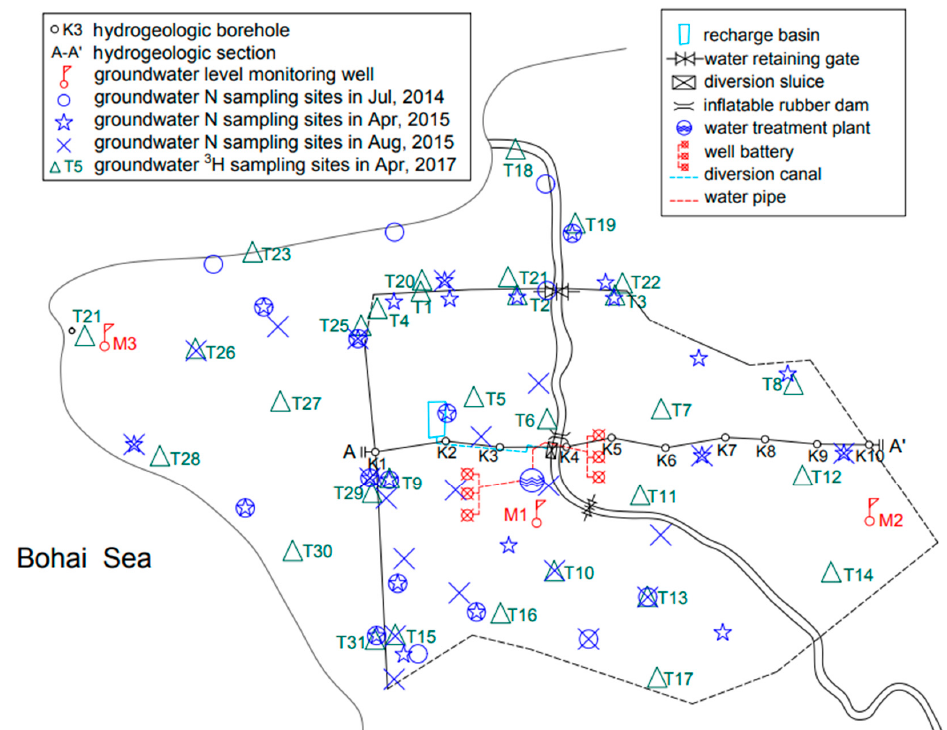
Figure 3. Layout of the Wanghe artificial underground reservoir, location of groundwater sampling sites, groundwater level monitoring wells, and hydrogeological section.